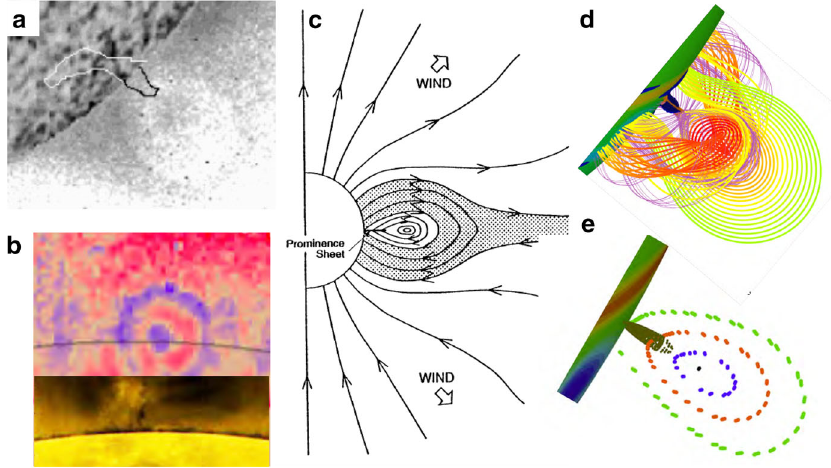
Fig.13 Hotcoresandbullseyeflowsexistwithinlargercavityvolume,perchedatopprominences. a Yohkoh observation of long-lived hot SXR core (inverse image); location of H α prominence indicated by contour. ImagereproducedwithpermissionfromHudsonetal.(1999),copyrightbyAAS. b (Tophalf)Bullseyeline- of-sight flows observed by CoMP telescope within cavity; (bottom half) AIA 193 observations indicating presence of larger-scale cavity surrounding bullseye and central prominence (seen in absorption) beneath it. Image adapted from Ba˛k-Ste˛´slicka et al. (2016). c Cartoon of cross section of flux rope embedded in closed and open fields. Image reproduced with permission from Low (1996), copyright by Springer. d Field lines within flux rope color-coded by temperature demonstrating the hot core lying above the dipped magnetic fields (brown) associated with prominence (from Gibson 2015); and e intersection of flux rope flux surfaces with plane of sky (colored dots). Image reproduced with permission from Forland et al. (2013), copyright by the authors